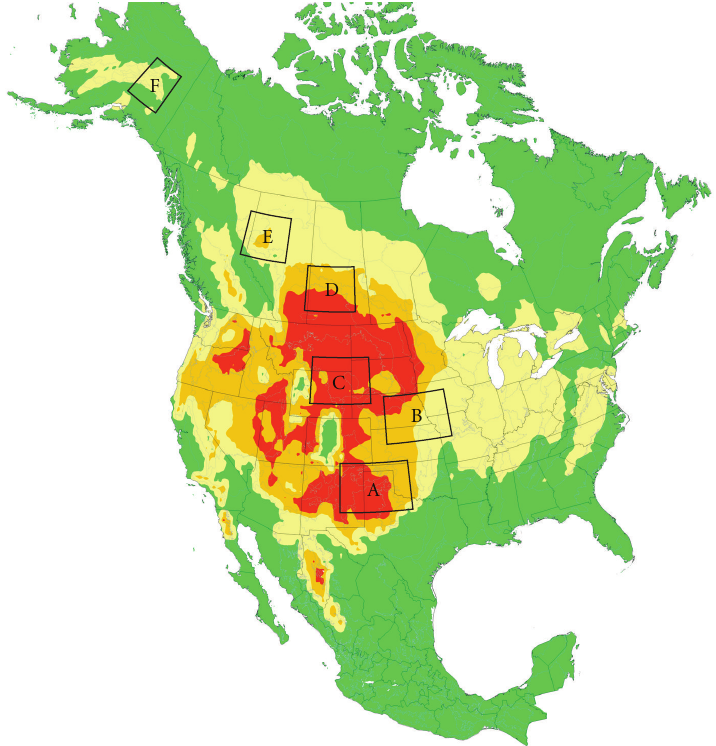
Figure 1: Predicted distribution and abundance (EI) of Melanoplus sanguinipes for current climate (CRU) at six regions: (A) Lubbock, TX; (B) Lincoln, NE; (C) Gillette, WY; (D) Saskatoon, SK; (E) Peace River, AB; (F) Fairbanks, AK. Green = “Unfavourable” (EI = 0 − 5); Tan = “Suitable” (EI = 5 − 20); Orange = “Favourable” (EI = 20 − 30); Red = “Very Favourable” (EI ≥